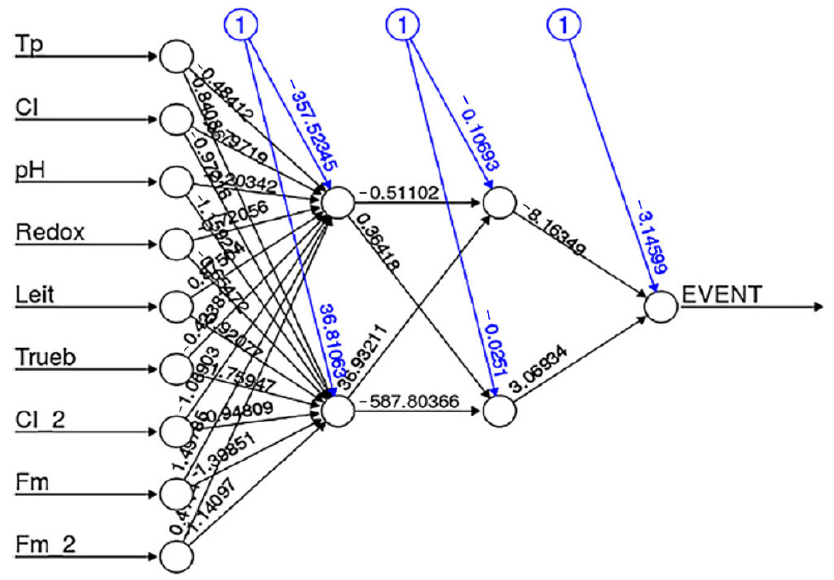
Figure 10. Proposed model for water quality anomalies